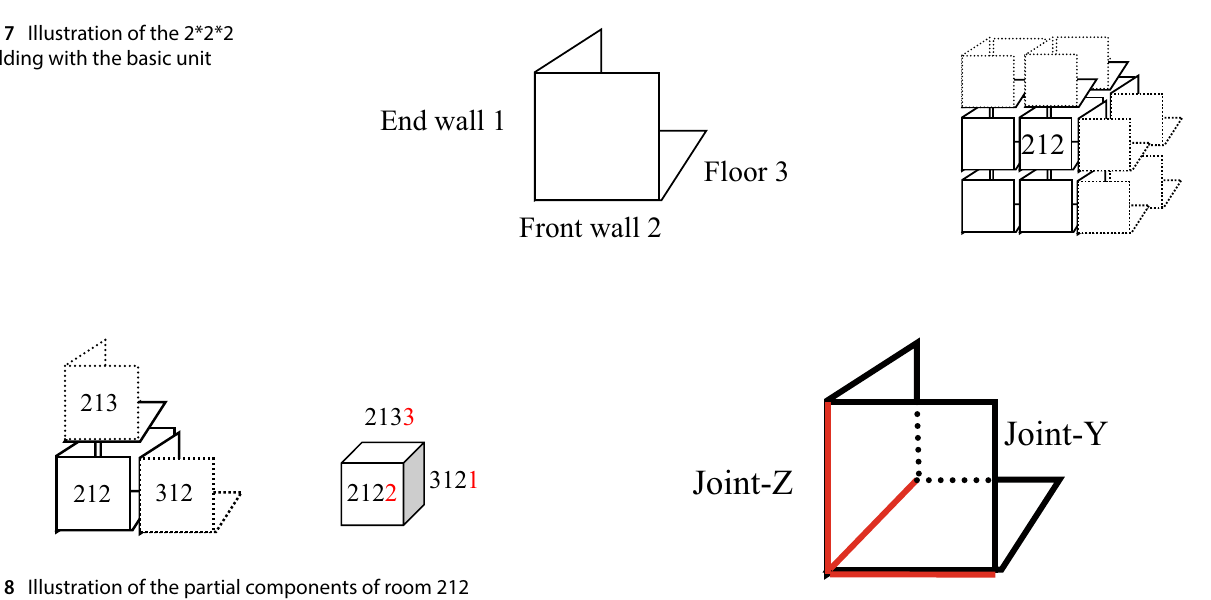
Fig. 8 Illustration of the partial components of room 212